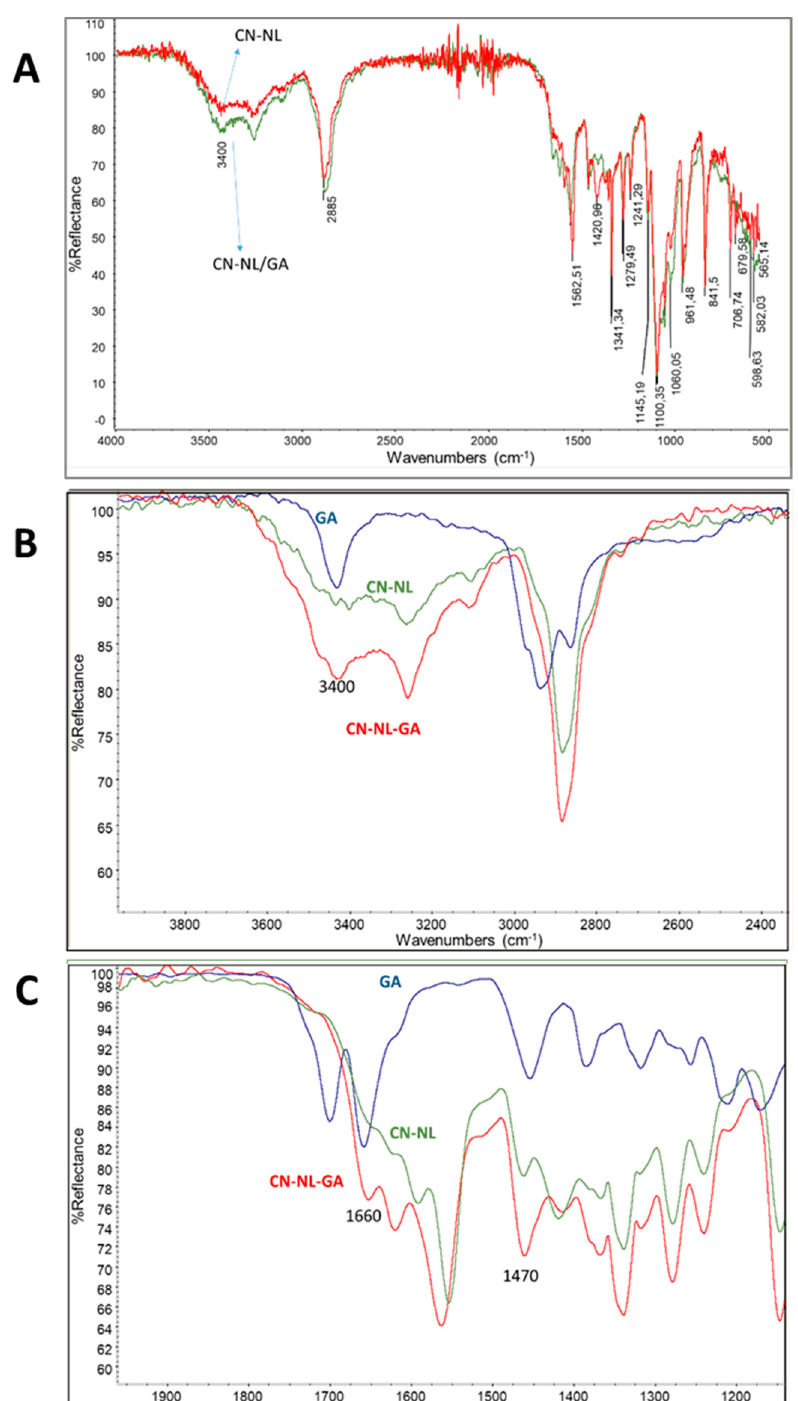
Figure 4. Infrared ATR spectra of ( A ) CN-NL and CN-NL/GA powders; ( B ) CN-NL, CN-LN/GA and GA in the region 2400-4000 cm -1 ; ( C ) CN-NL, CN-LN/GA and GA in the region 1100-2000 cm -1.